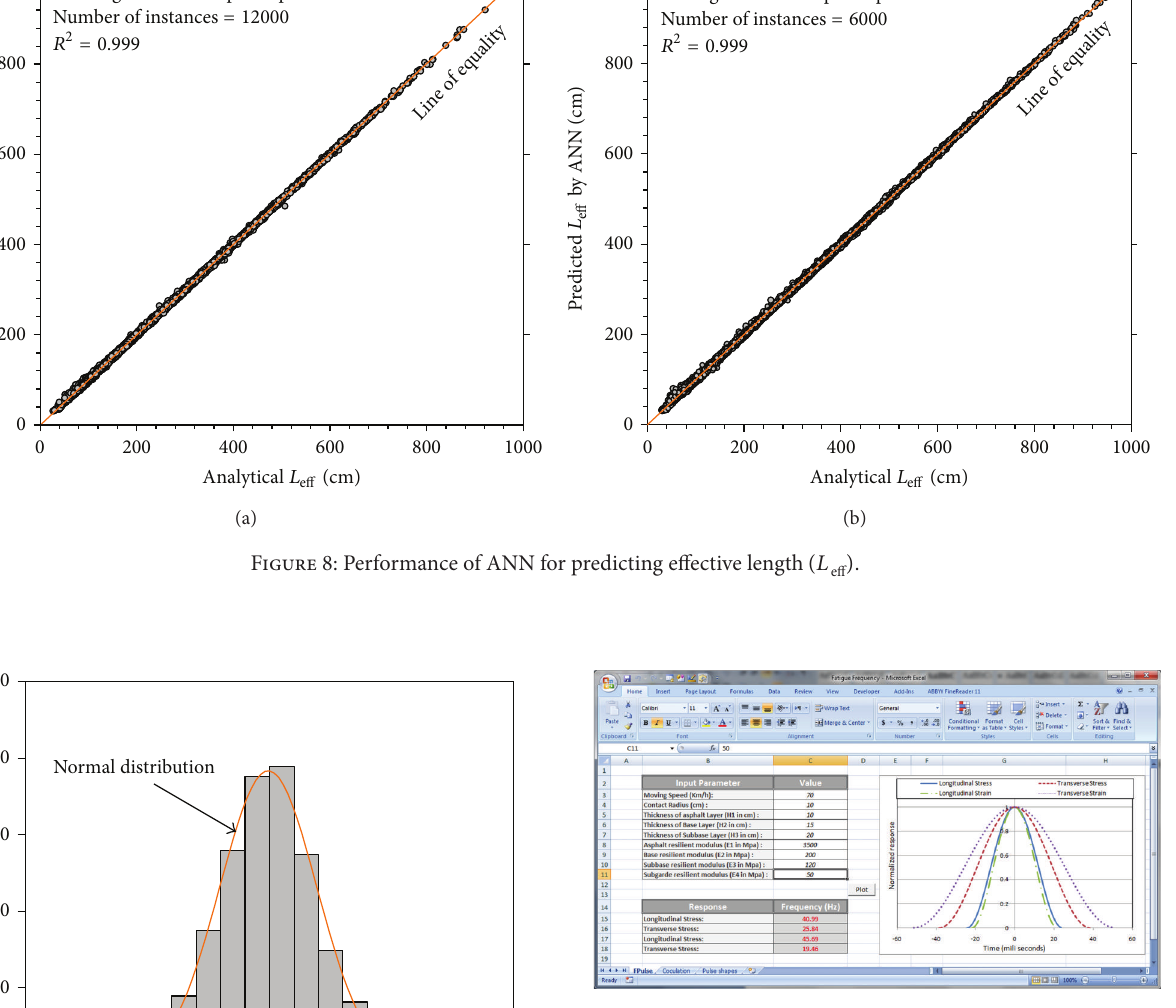
Figure 10: User interface of program for predicting loading fre- quency. Table 5: The standard pavement section for parametric